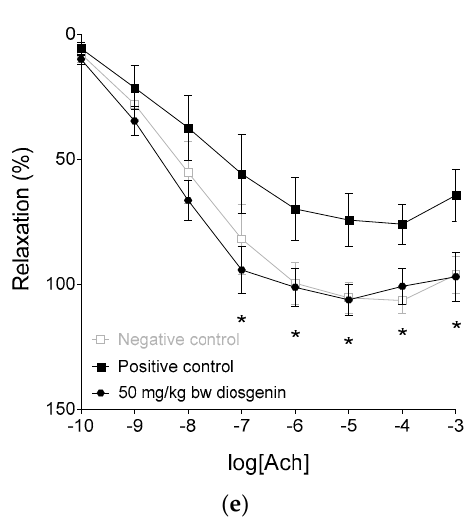
Figure 3. The effect of acetylcholine (Ach) on the abdominal aorta isolated from rats treated with dietary fenugreek seed flour (panel b ) or different doses of diosgenin in addition to high-fat, high-sugar diet (HFHSD) (panel c – e ), and from rats forming the positive (receiving HFHSD only) and negative (receiving conventional rat food and tap water) controls (panel a ). All aortic rings underwent a pre-contraction evoked by norepinephrine (NE) before the administration of Ach. The axis x shows the common logarithm of molar concentration of Ach, while the axis y indicates the effect as a percentage decrease of the initial contractile force of aortic rings. The symbols represent the effect of Ach averaged within the groups (±SEM). Asterisks denote the significance level of differences between groups indicated with black colored symbols and lines (*: p < 0.05; **: p < 0.01).